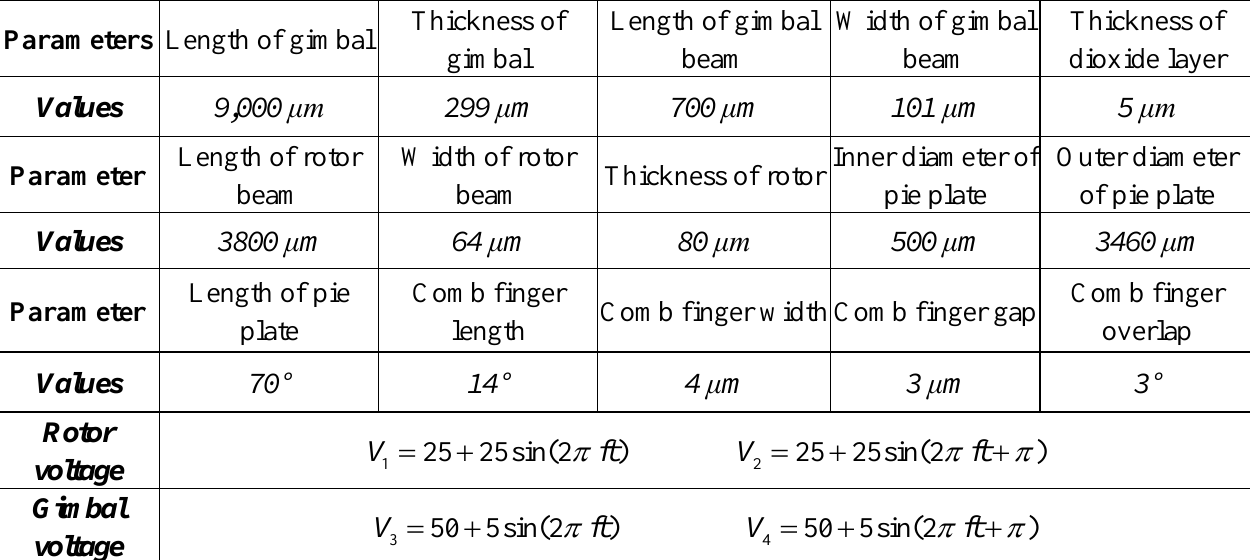
Table 1. Major parameters for the